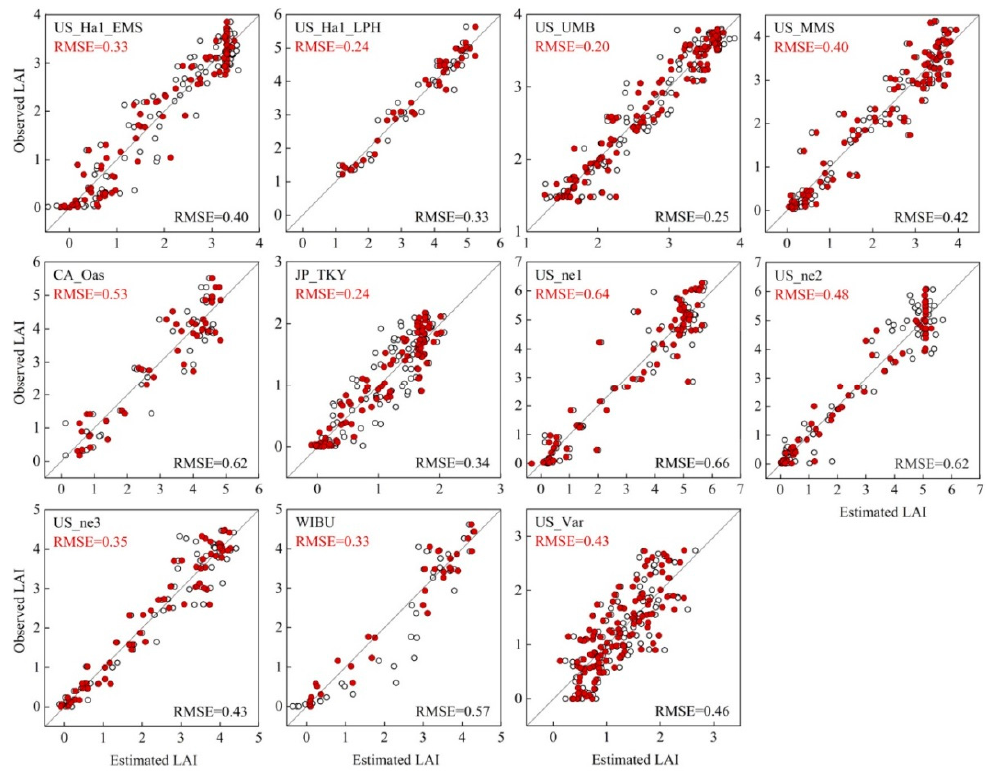
Figure 3. Scatter plots of the observed LAIs versus LAIs estimated with the piecewise LAI-normalized difference vegetation (NDVI) relationship (red solid circle) and the single LAI-NDVI relationship (black open circle).